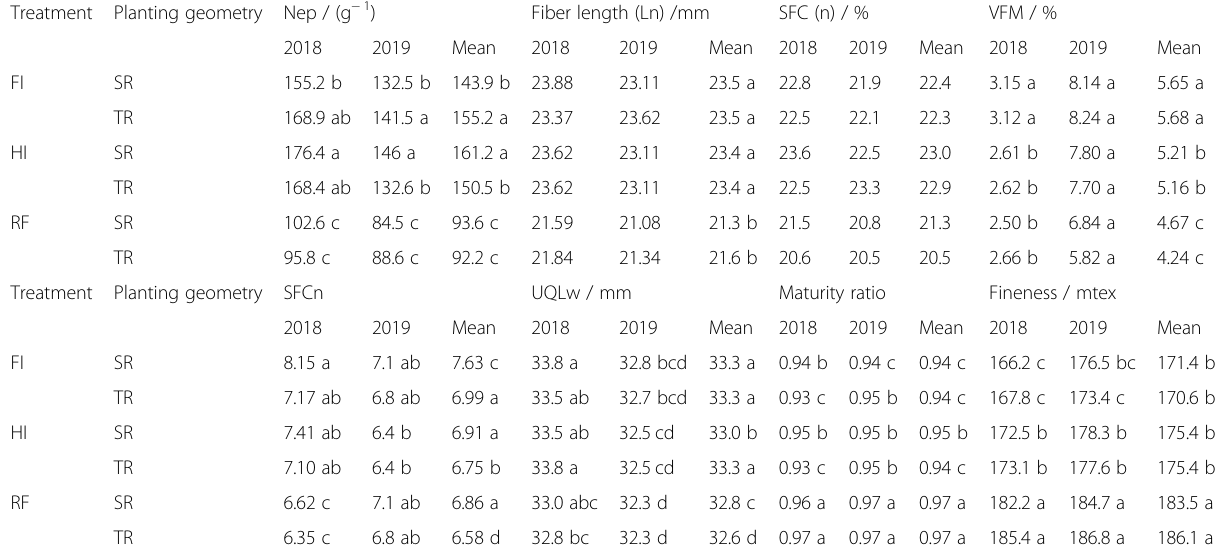
Table 3 Fiber quality characteristics of full irrigated (FI) and half irrigated (HI) and rain-fed (RF) cotton grown in Dundee silt loam with single-row (SR) and twin-row (TR) planting geometries estimated by advanced fiber information systems (AFIS) Treatment Planting geometry Nep / (g − 1